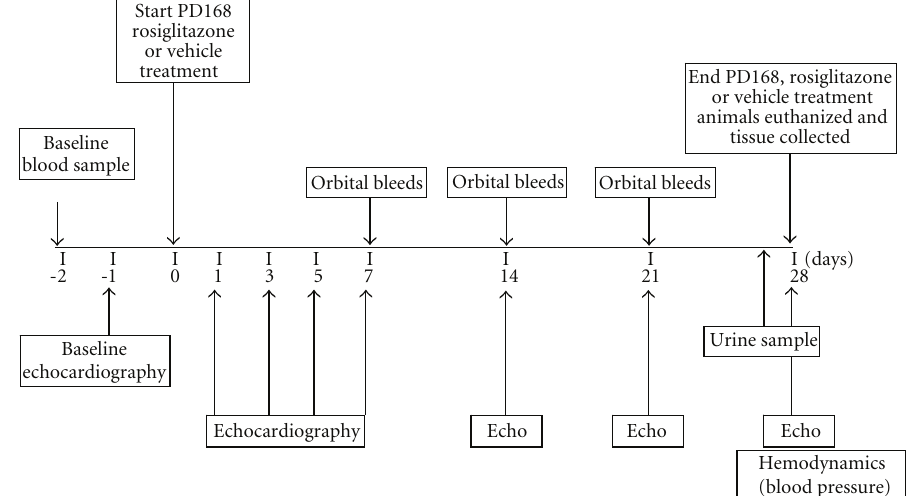
Figure 1: Schematic diagram of study design; echocardiography,